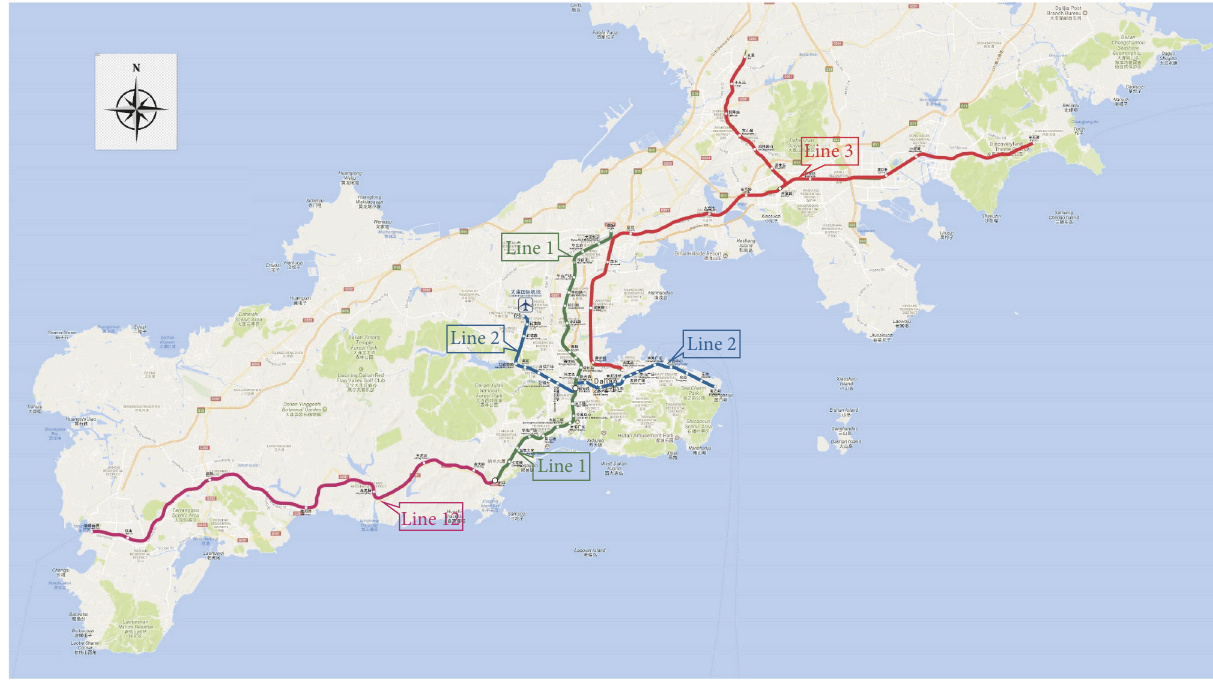
Figure 1: Distribution of the railway transportation in